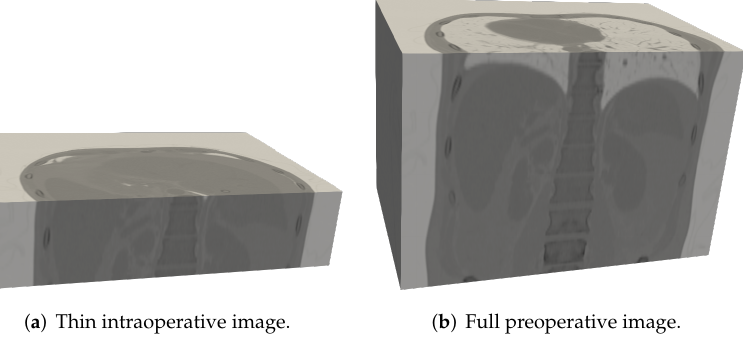
Figure 1. Examples of CT images: The thin image ( a ) displays a reduced field of view (thickness) with respect to the z axis, as compared to the full preoperative image ( b ).